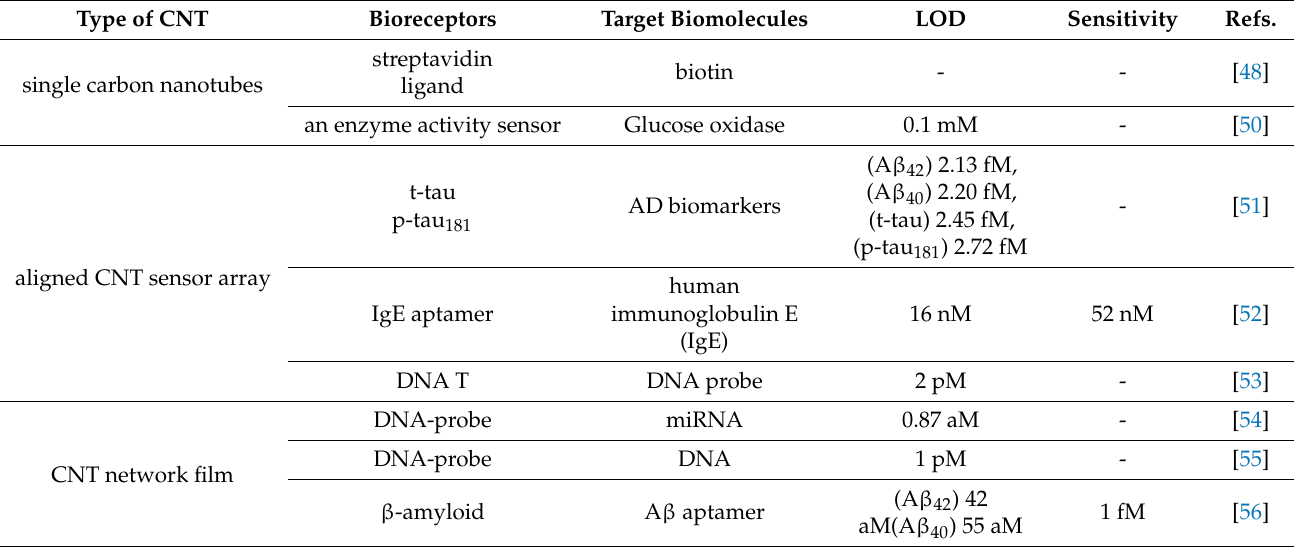
Table 1. Bio–CNTFET-based detection of various biomarkers.